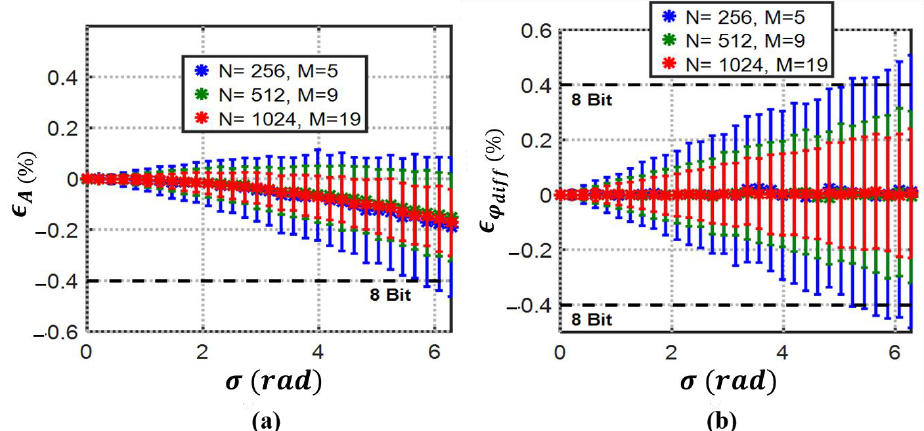
Figure 8. 3PSF ( a ) percent mean amplitude and ( b ) percent mean differential phase estimation errors with their normalized standard deviations (error bars) vs. jitter standard deviation ( σ ). 3PFS can maintain 8-bit resolution with even unrealistic jitter standard deviations close to 2 π by record length control at 55 kS/s sampling rate.